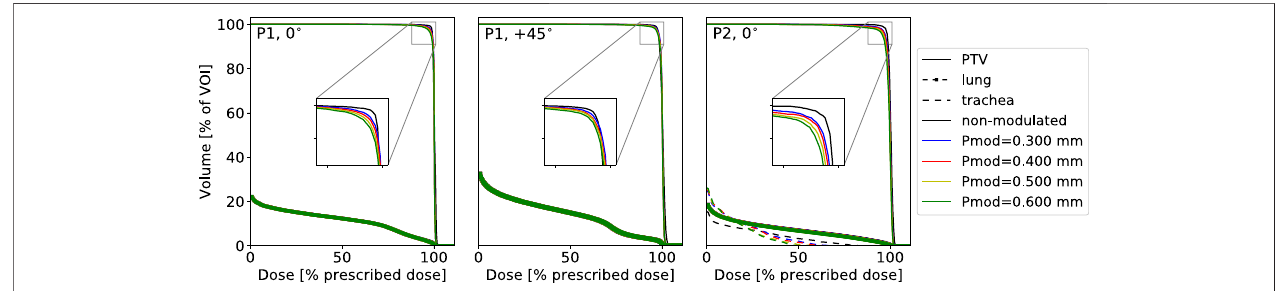
FIGURE 7 | DVHs of selected VOIs for proton plans on the non-modi fi ed CTs compared to plans on n (cid:1) 100 summed modi fi ed CTs with different P mod values. ThreetreatmentplanningcasesareshownforP1plannedwithahorizontal fi eldaswellaswithoneoblique fi eldat+45 ° aswellasforP2withahorizontal fi eld.Planswere optimized and calculated for physical dose with a 3 × 3 mm 2 raster scan size and a depth step size of 3 mm P1 and 2 mm for P2.